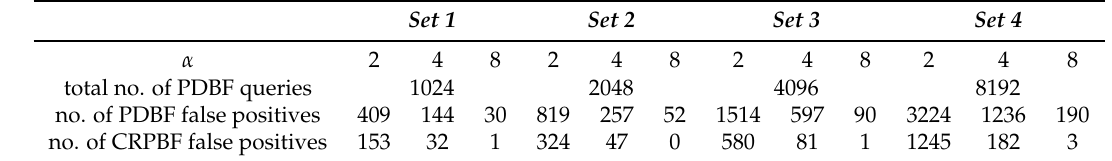
Table 3. Bloom filter